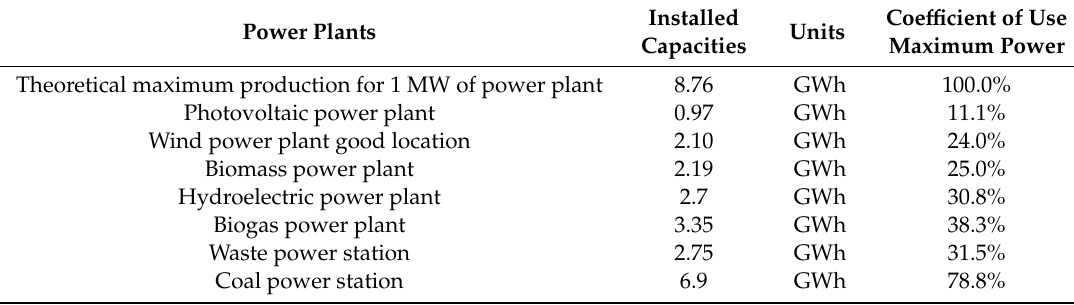
Table 6. Maximum power utilization rate. Power